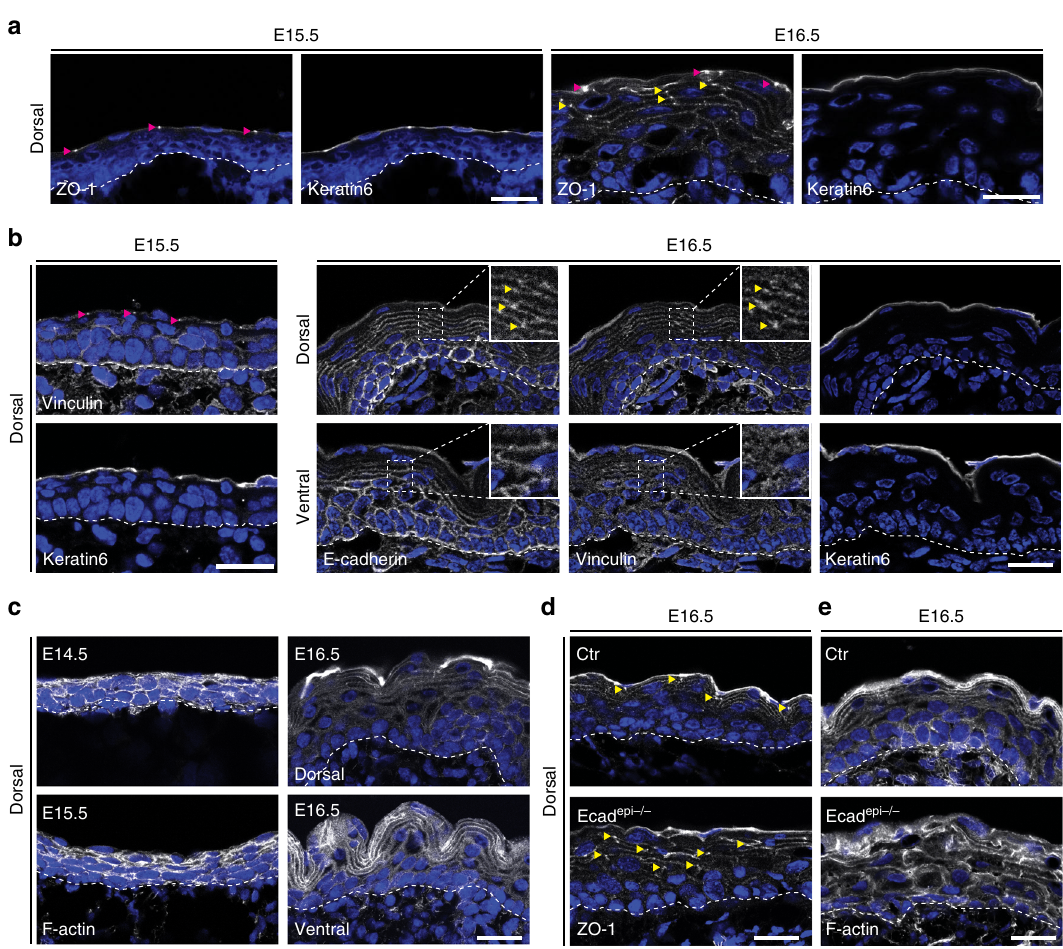
Fig. 4 E-cadherin spatiotemporally coordinates the formation of tension-high adherens junctions, tight junctions, F-actin, and barrier function. a – e Immunohistochemistry analysis on mouse embryonic skin before (E15.5, E16.5 ventral) and after (E16.5, dorsal) epidermal barrier formation for a TJ marker ZO-1 showing that TJ formation in uppermost layer (yellow arrowheads) coincides with barrier formation. Peridermal TJs are marked by magenta arrowheads. b Staining for vinculin showing that suprabasal, junctional recruitment (yellow arrowheads) coincides with barrier formation. Keratin-6 was used to identify periderm ( a , b ). c Phalloidin staining showing F-actin organization and polarization. d , e . Staining for ZO-1 d and Phalloidin e showing increased depolarization of ZO-1 junctional recruitment and F-actin organization upon loss of E-cadherin during barrier formation. a – c Representative image of n ≥ 3 biological replicates each. d , e Representative image of n = 2 biological replicates each. Nuclei were stained with DAPI (blue). Scale bars, 20 µ